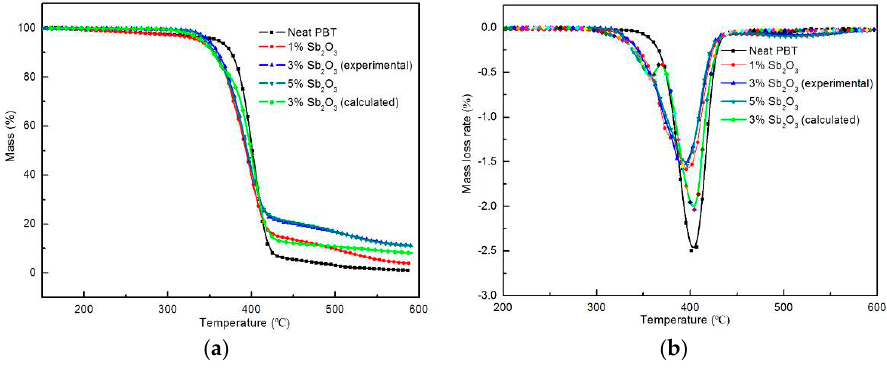
Figure 3. TGA ( a ) and DTG ( b ) curves of the neat PBT matrix and its composites under nitrogen.